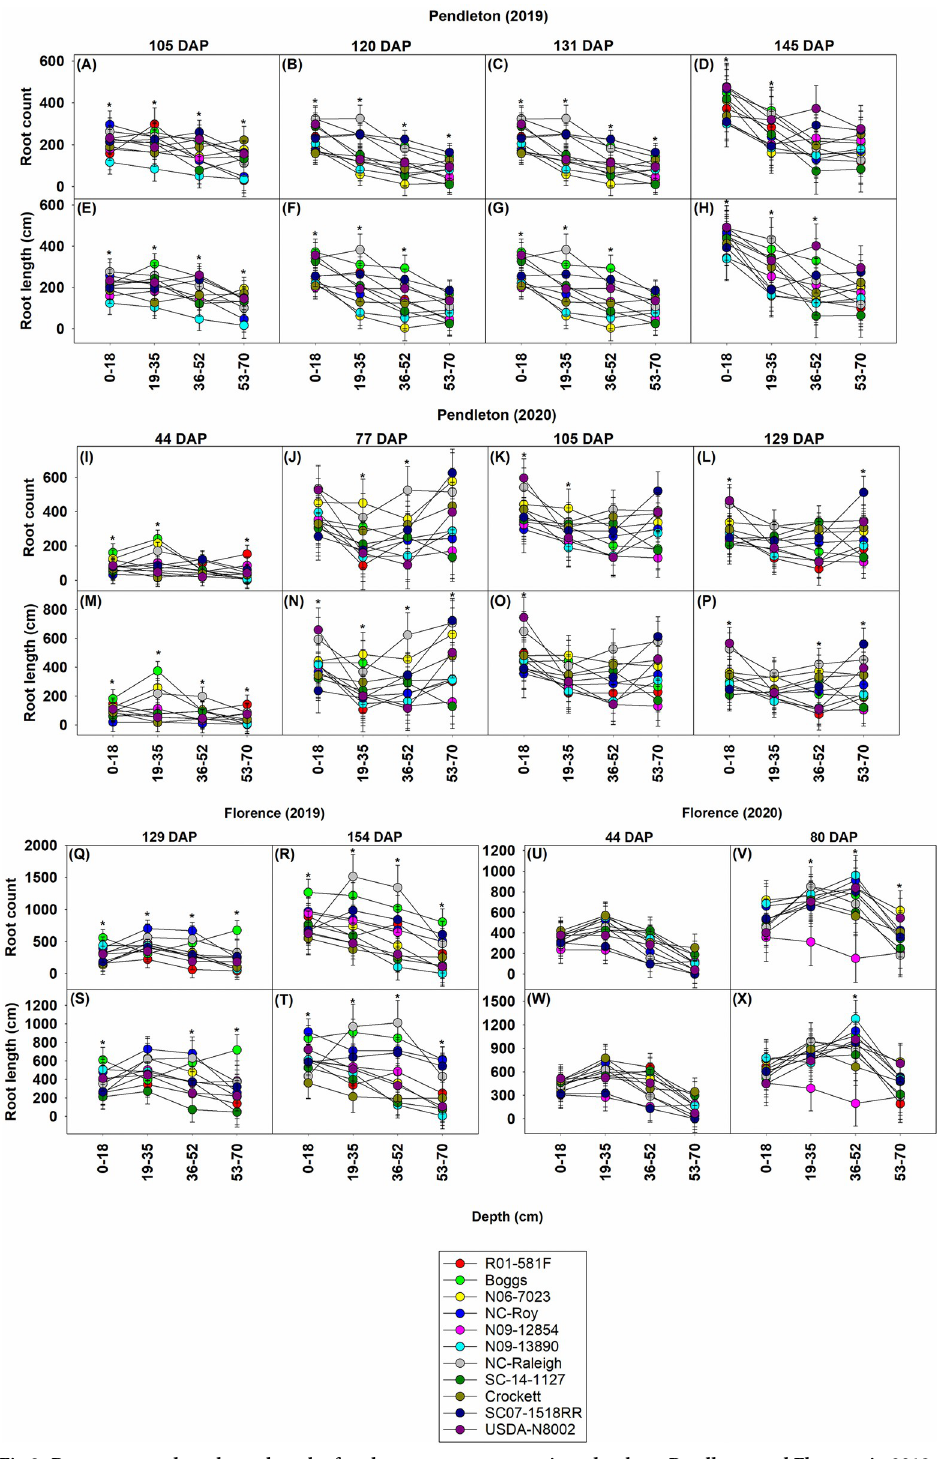
Fig 8. Root count and total root length of soybean genotypes at various depths at Pendleton and Florence in 2019 and 2020. Root count is the number of roots visible in the imaging area of the CI-602 root imager. Root length is the sum of the lengths of all roots visible in the imaging area of the CI-602 root imager. Asterisk shows differences among genotypes based on the Fisher’s least significant difference (LSD) test at α = 0.05. DAP–days after planting. Most genotypes reached R1 or R2 growth stage by 105 DAP, R4 growth stage by 120 DAP, R5 or R6 growth stage by 131